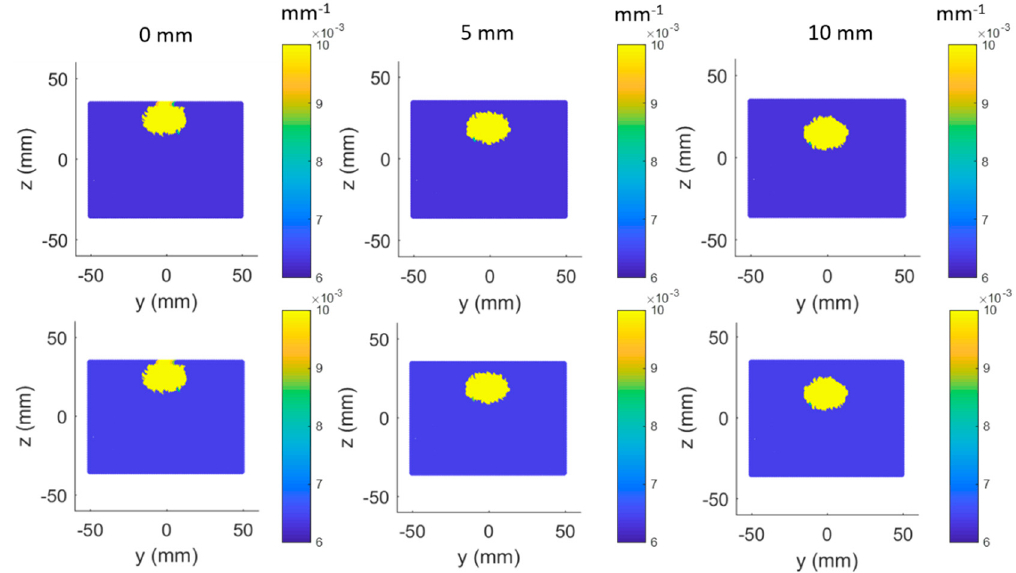
Figure 6. Ground truth (row 1) versus simulated recovery (row 2) in µ a (650 nm) at different tumor depths (columns).